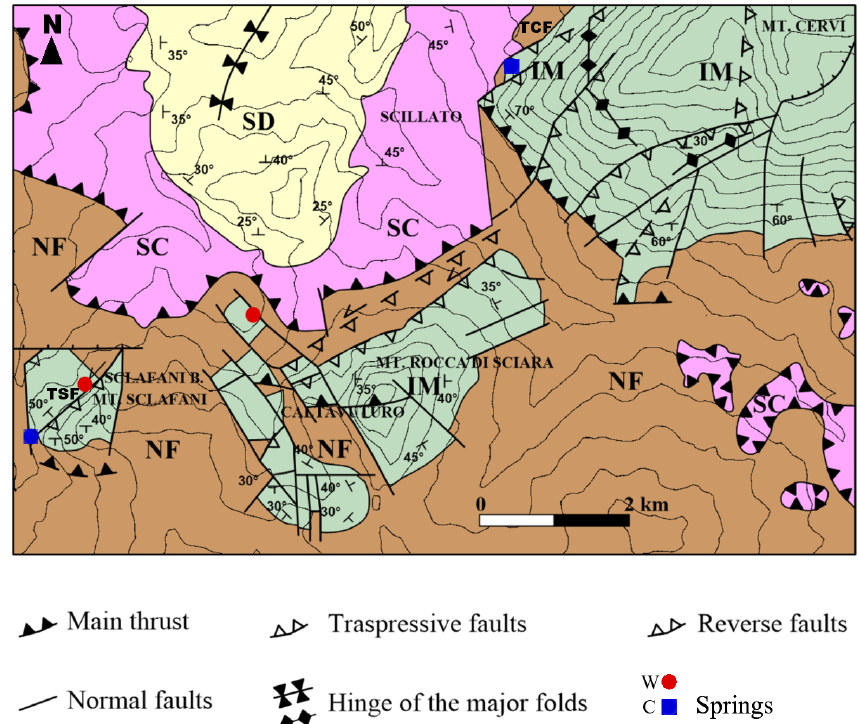
Figure 2. Simplified structural sketch of the study area showing the Cervi-Rocca Sciara-Sclafani Anticlinorium. SD (Syntectonic deposits); NF (Numidian Flysch, cap rock); SC (Sicilidi Units); IM (Imerese Units, multilayered reservoir). TSF (Transpressional Sclafani Fault); TCF (Transpressional Cervi Fault). Drawing modified after Catalano et al. (2011b), Gugliotta and Gasparo Morticelli (2013).